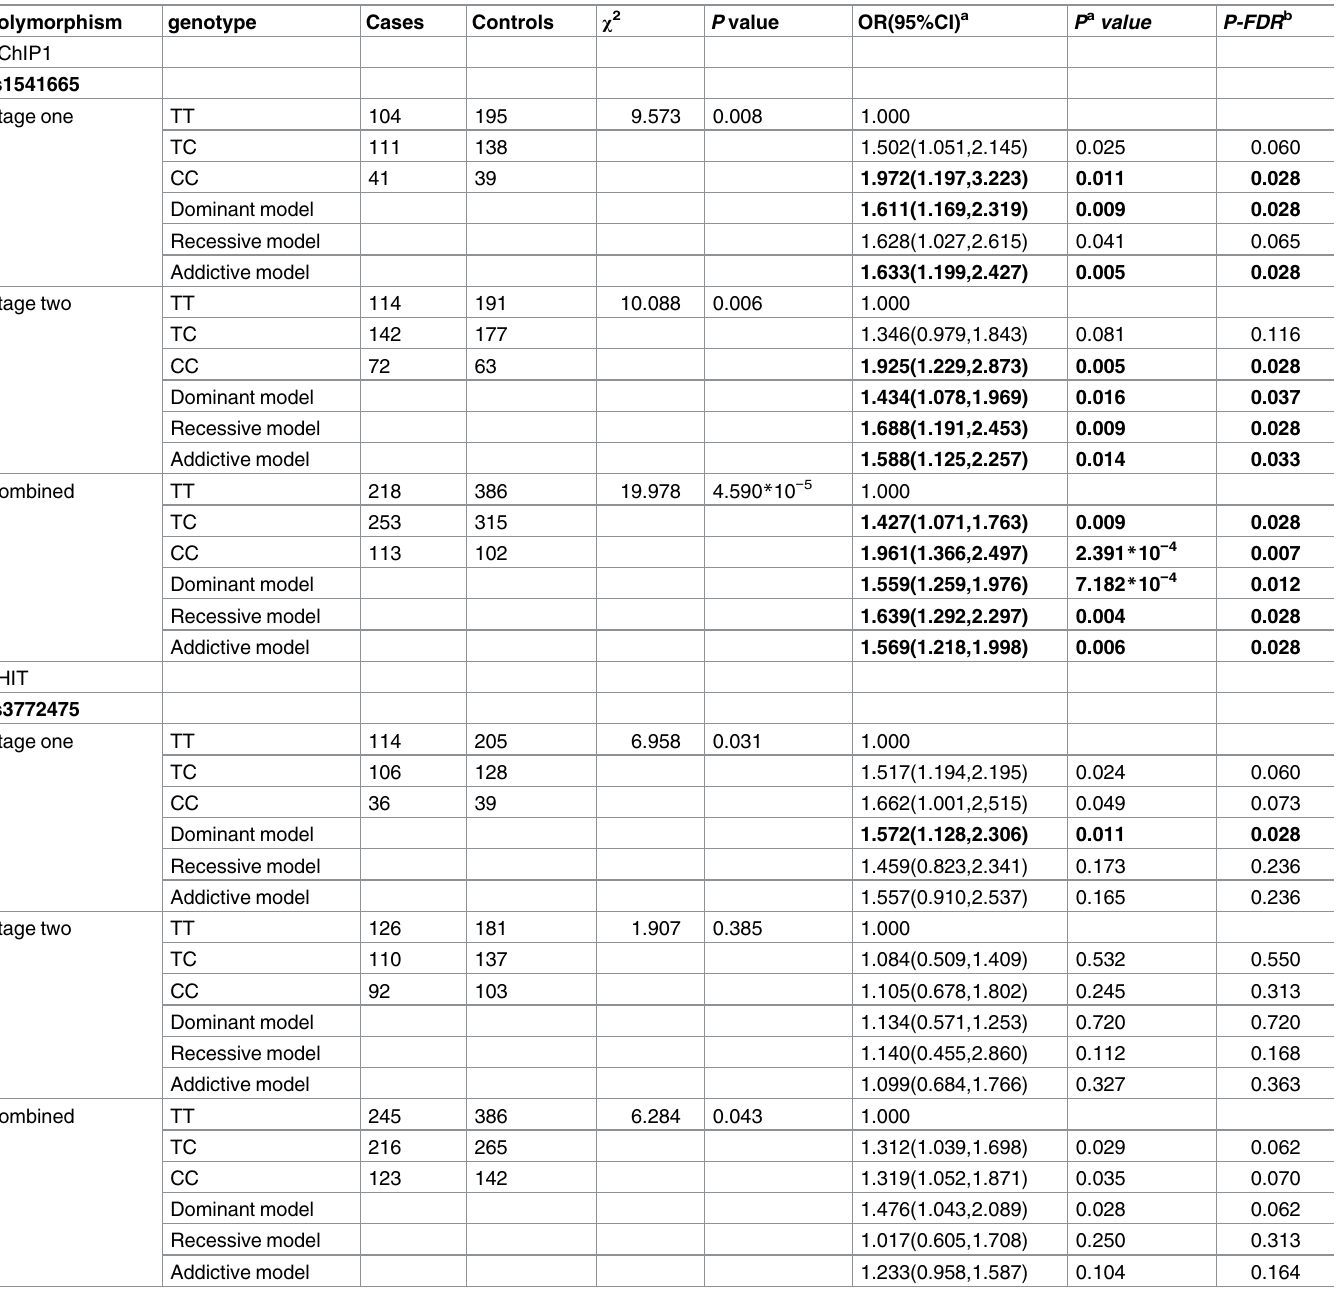
Table 2. Association between promising polymorphism genotypes and ADHD risk in all